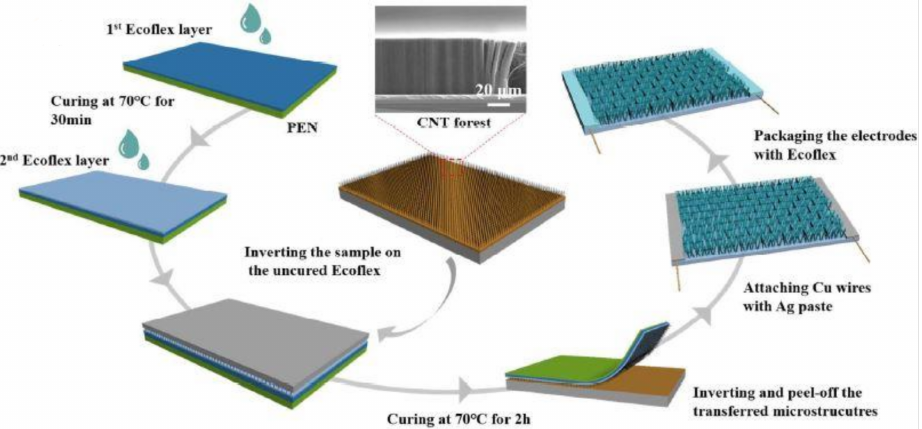
Figure 1. Fabrication of flexible strain sensors using carbon nanotubes (CNTs) and EcoFlex nanofin structures [97]. Reproduced from Zhang, S.; Wen, L.; Wang, H.; Zhu, K.; Zhang, M. Vertical CNT– EcoFlex nanofins for highly linear broad-range-detection wearable strain sensors. J. Mater. Chem. C 2018 , 6 ,